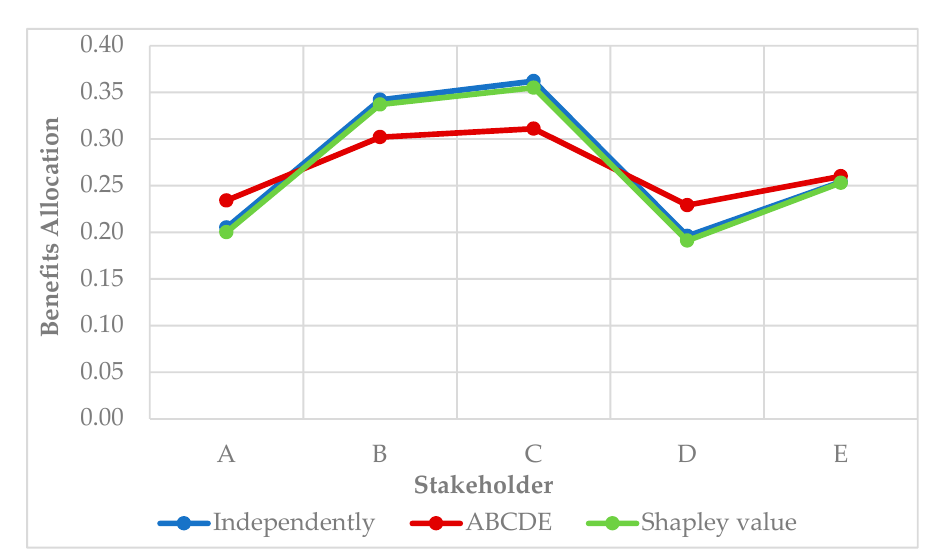
Figure 6. Comparison of coalition distributions.